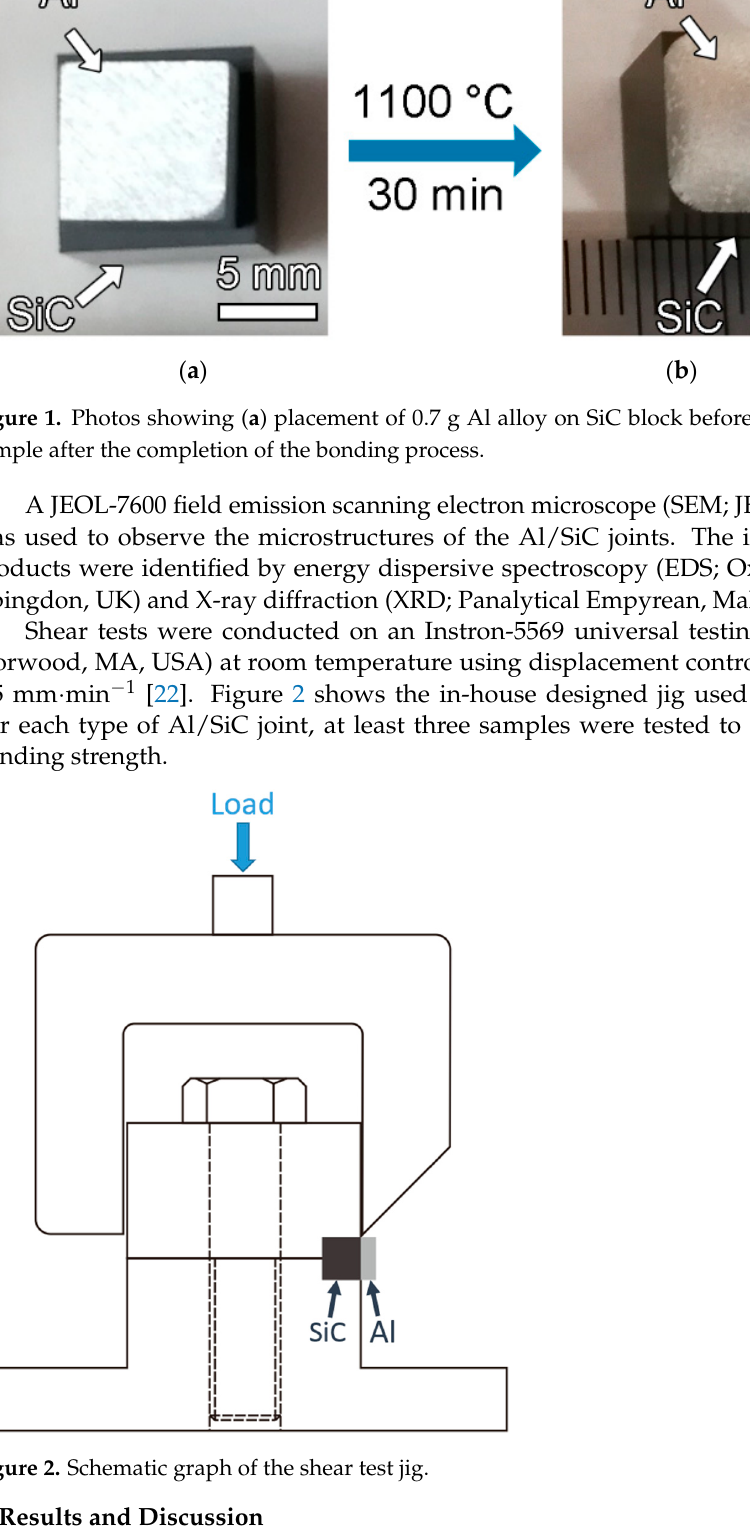
Figure 2. Schematic graph of the shear test jig.